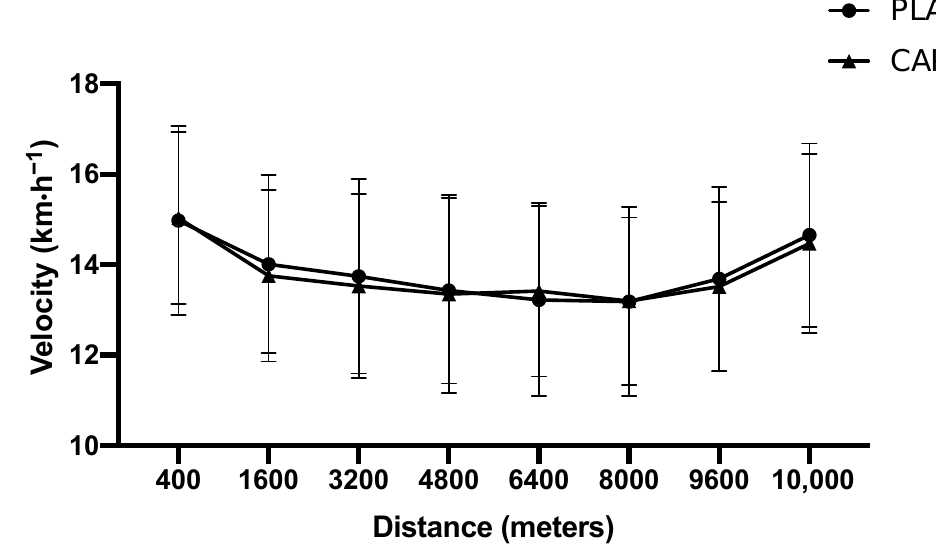
Figure 3. Delta individuals’ values of time-trial (PLA-CAP).